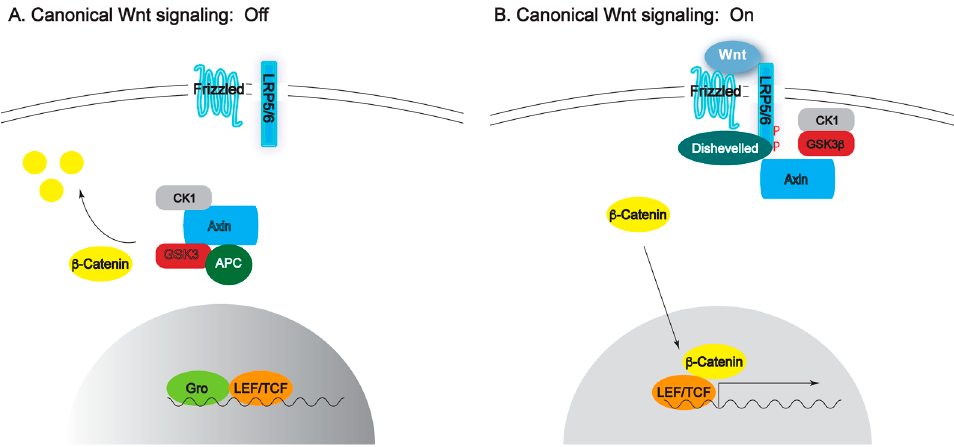
Figure 1 . Cont. Figure 1.